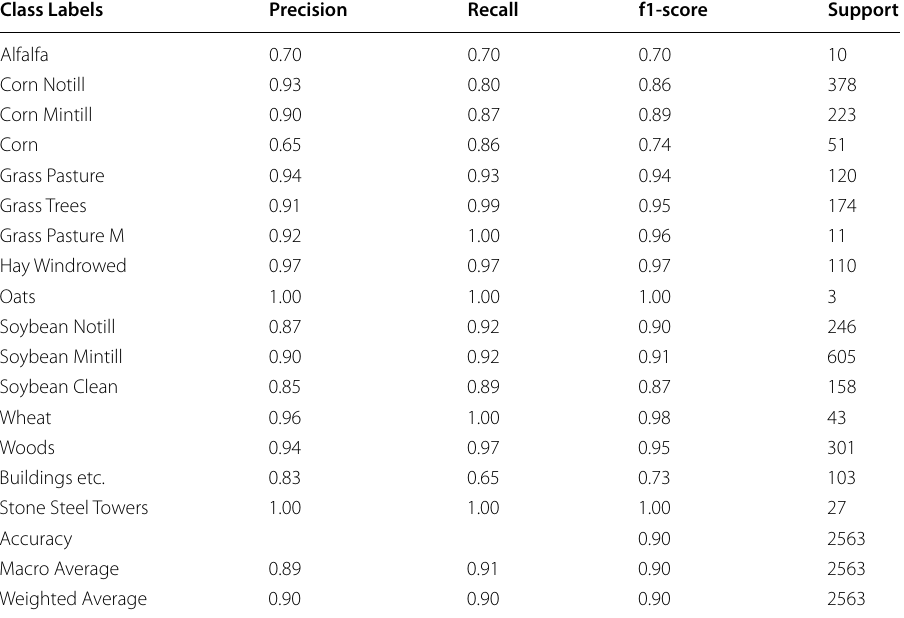
Table 12 Detailed classification test results for the Indian Pines Dataset in terms of Precision, Recall, and F1-Score. Testing was done with PCA 30 CEU-Net no-patching with a 75%/25%